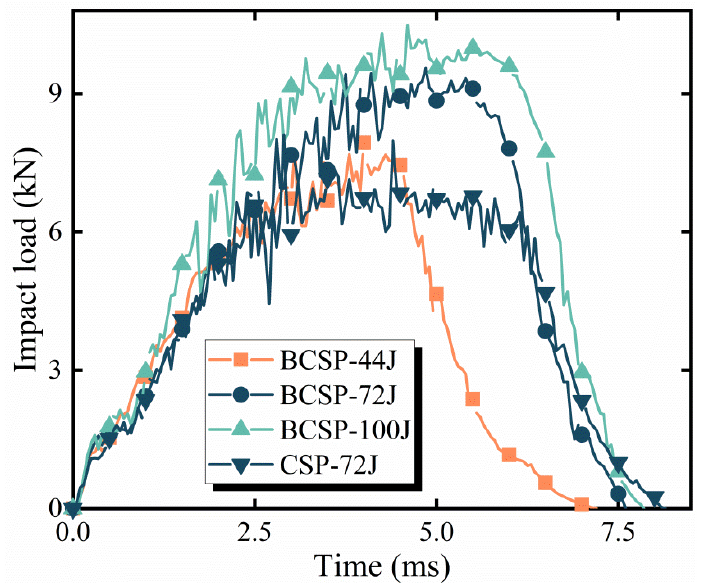
Figure 10. Impact load – time curves of the BCSP.